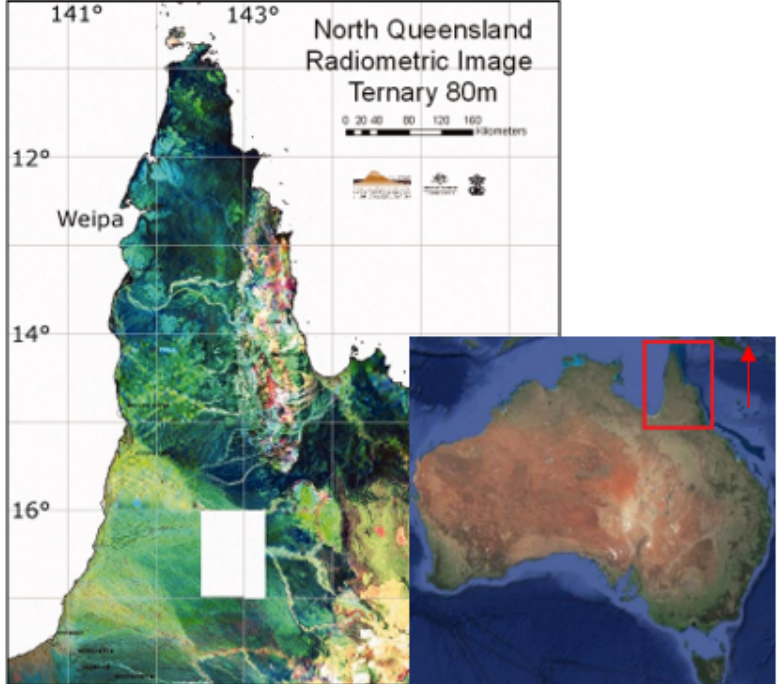
Figure 1. A radiometric image of the Weipa area of interest in North Queensland, Australia. The blue colouring around Weipa reflects the bauxite covering of the Weipa plateau. This image was reproduced from reference [23] and was originally prepared by M. A. Craig (Geoscience Australia). The inset image (from google.com/maps/, accessed 30 June 2021) shows the site location relative to Australia, with the arrow indicating north.